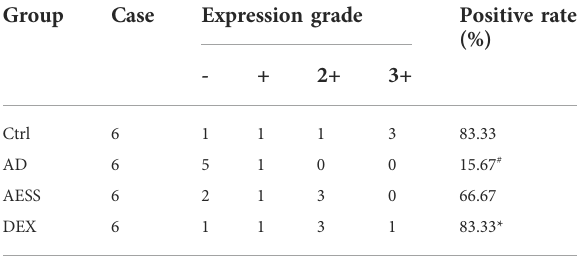
TABLE 6 The expression of YAP in mice skin lesions.